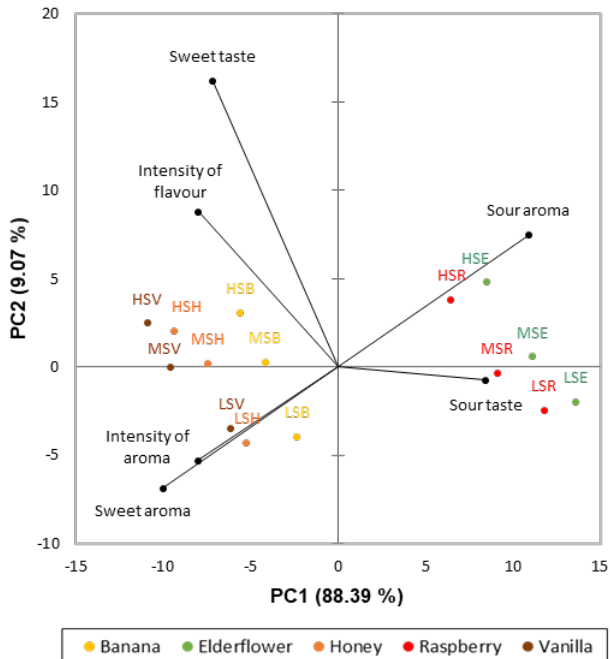
Figure 2. Principal Component Analysis biplot of the results from the DA. Attributes are marked in black while samples are colored according to aromas and coded according to sucrose concentration: LS = low sucrose concentration, MS = medium sucrose concentration, HS = high sucrose concentration, and aroma type: B = banana aroma, E = elderflower aroma, H = honey aroma, R = raspberry aroma, and V = vanilla aroma.